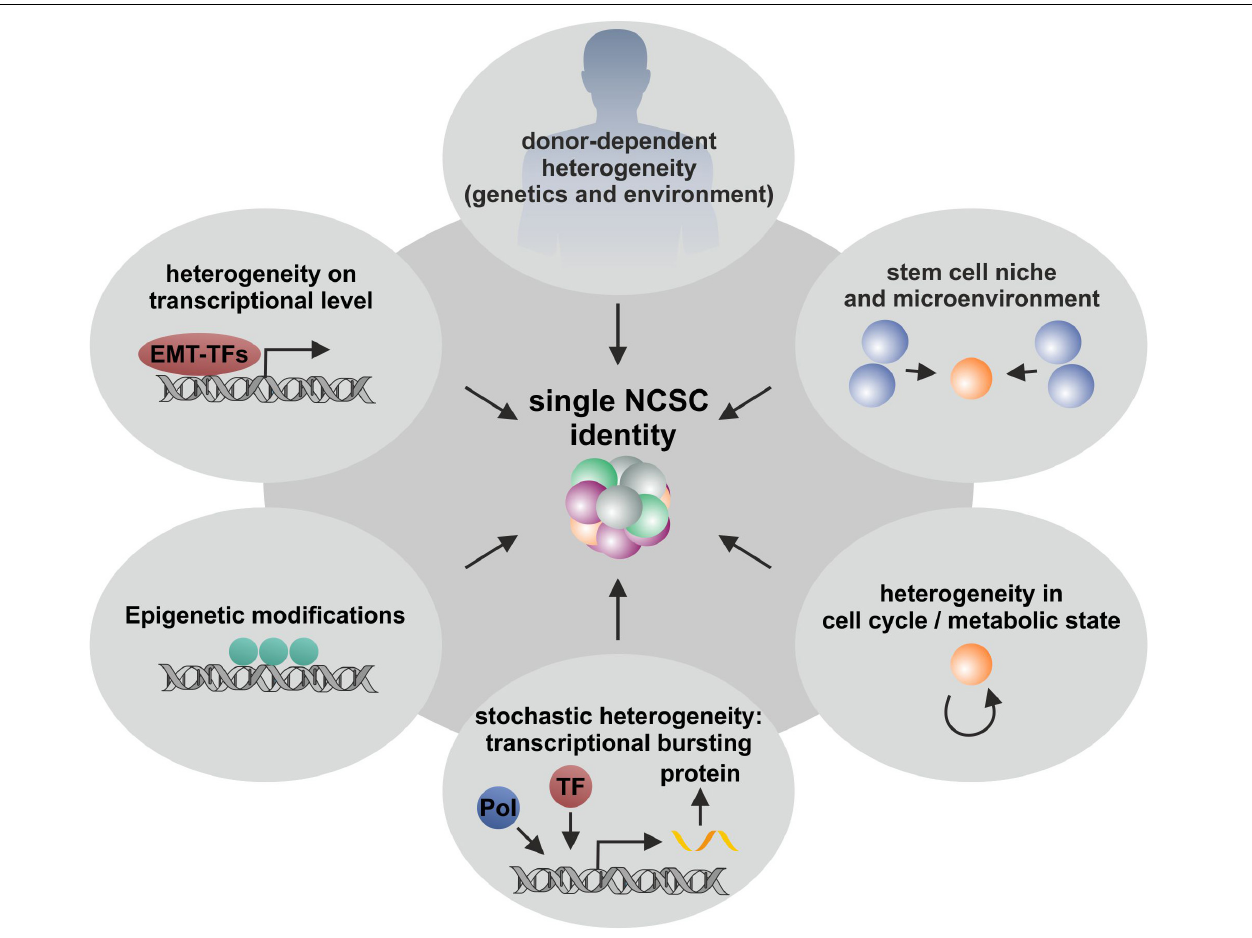
FIGURE 6 | Schematic illustration of various extrinsic and intrinsic factors influencing NCSC heterogeneity. Single stem cell heterogeneity is influence by diverse variables including donor-to-donor variations, the stem cell niche, epigenetic modifications, stochasticity of mRNA and protein production and random segregation during cell division. All these aspects are involved in stem cell heterogeneity and are crucial for the development and the existence of multicellular